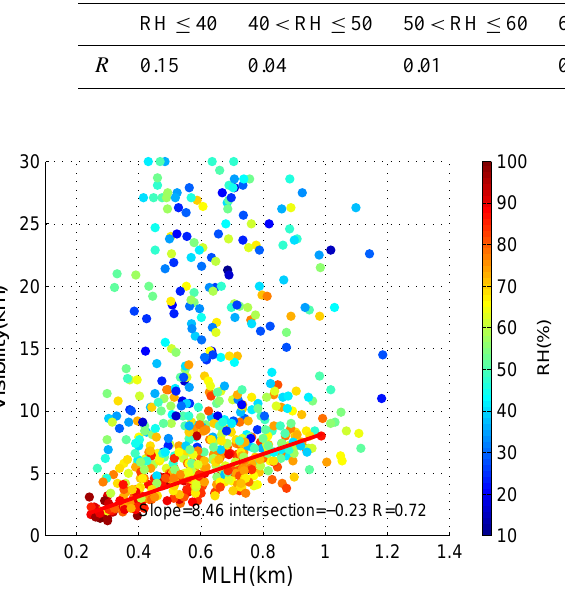
PM 1 under different degrees of air pollution in